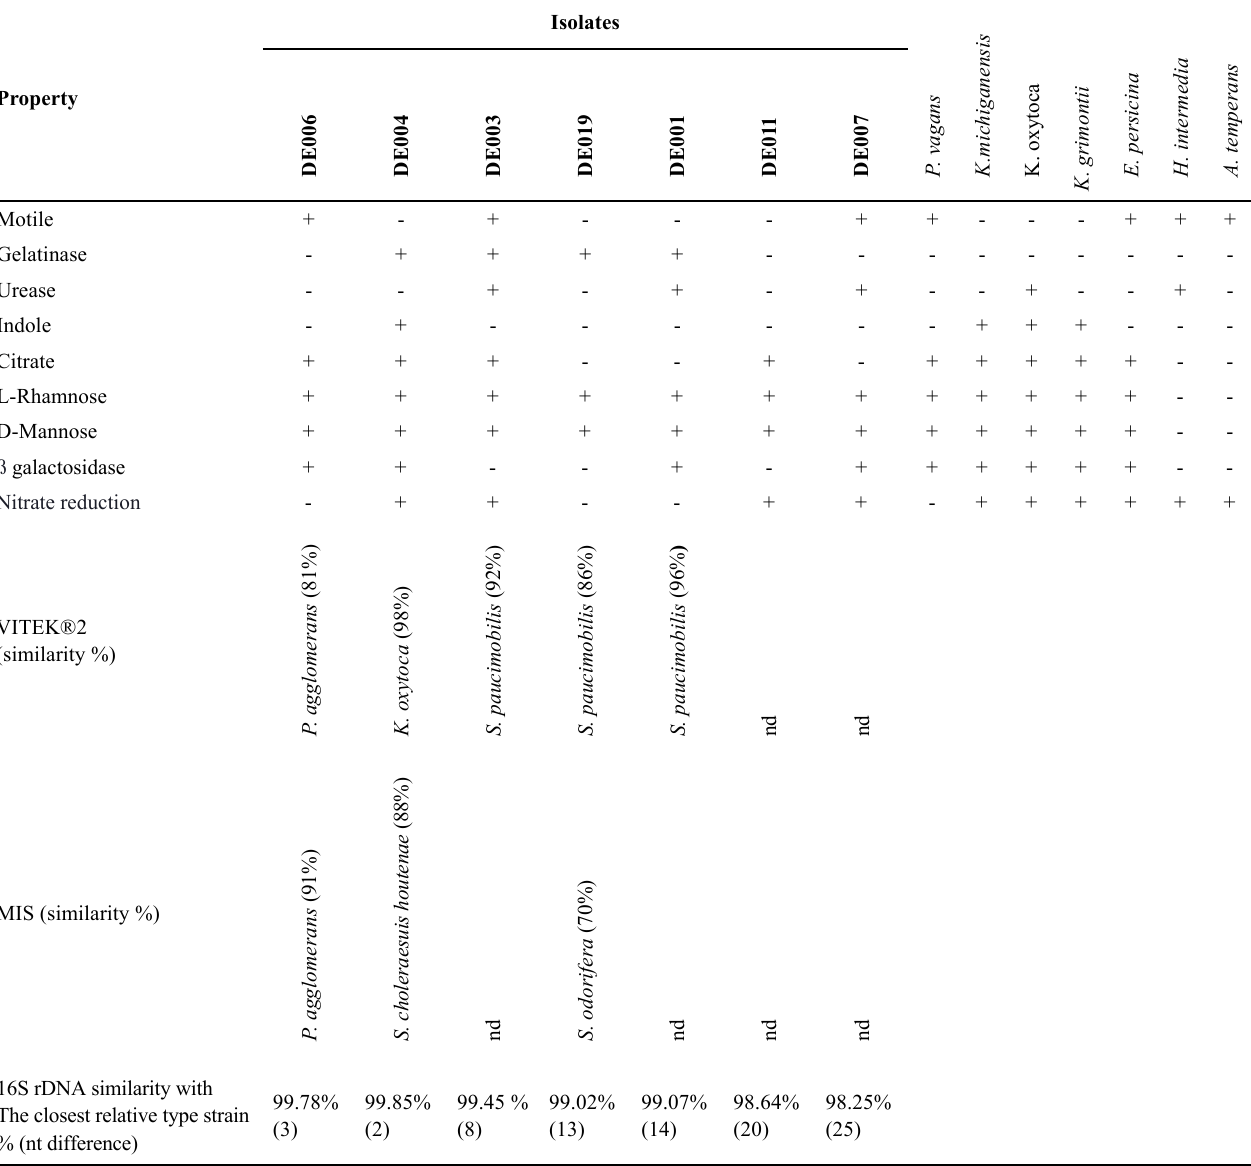
Table 4. Comparisons of the Gram-negative isolatesand closely related type strains. Characteristics are scored as: -, negative reaction; +, positive reaction; nd, not